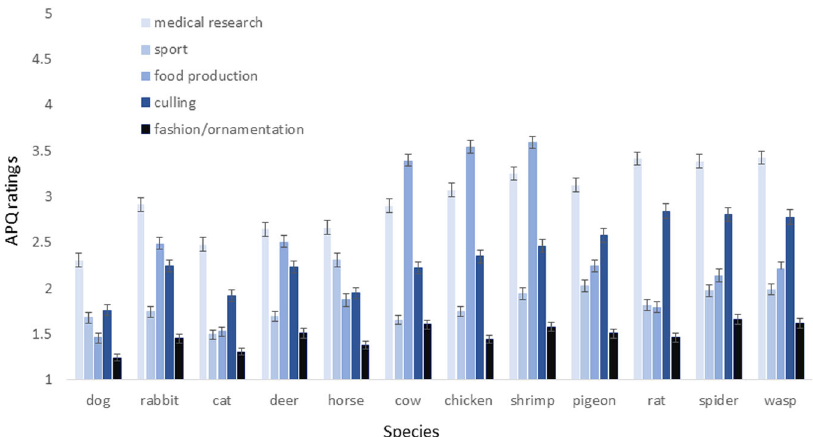
Fig. 3 The distribution of average APQ scores across species and purpose. Error bars show two standard errors of the mean. Scores of 3 indicate a neutral attitude, scores above 3 re fl ect some level of agreement and scores below 3 re fl ect varying levels of disagreement with the use of the listed animal species